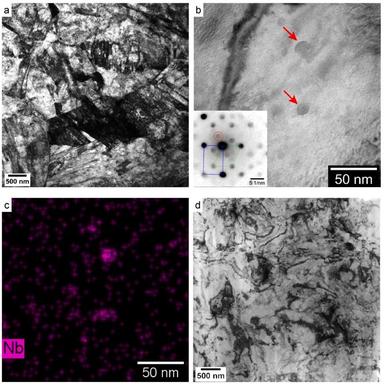
(a) TEM image of the as-received material (general view). (b) TEM image of the NbC (marked with red arrows) in the as-received material. The inserted image is a convergent beam electron diffraction pattern, in which the red circle highlighted spot corresponds to the NbC, the blue rectangle and green parallelogram match the diffraction patterns of bcc iron from zone axis of and . (c) The corresponding EDS map of area (b) showing the segregations of niobium. (d) TEM image of the sample after 90 J impact test